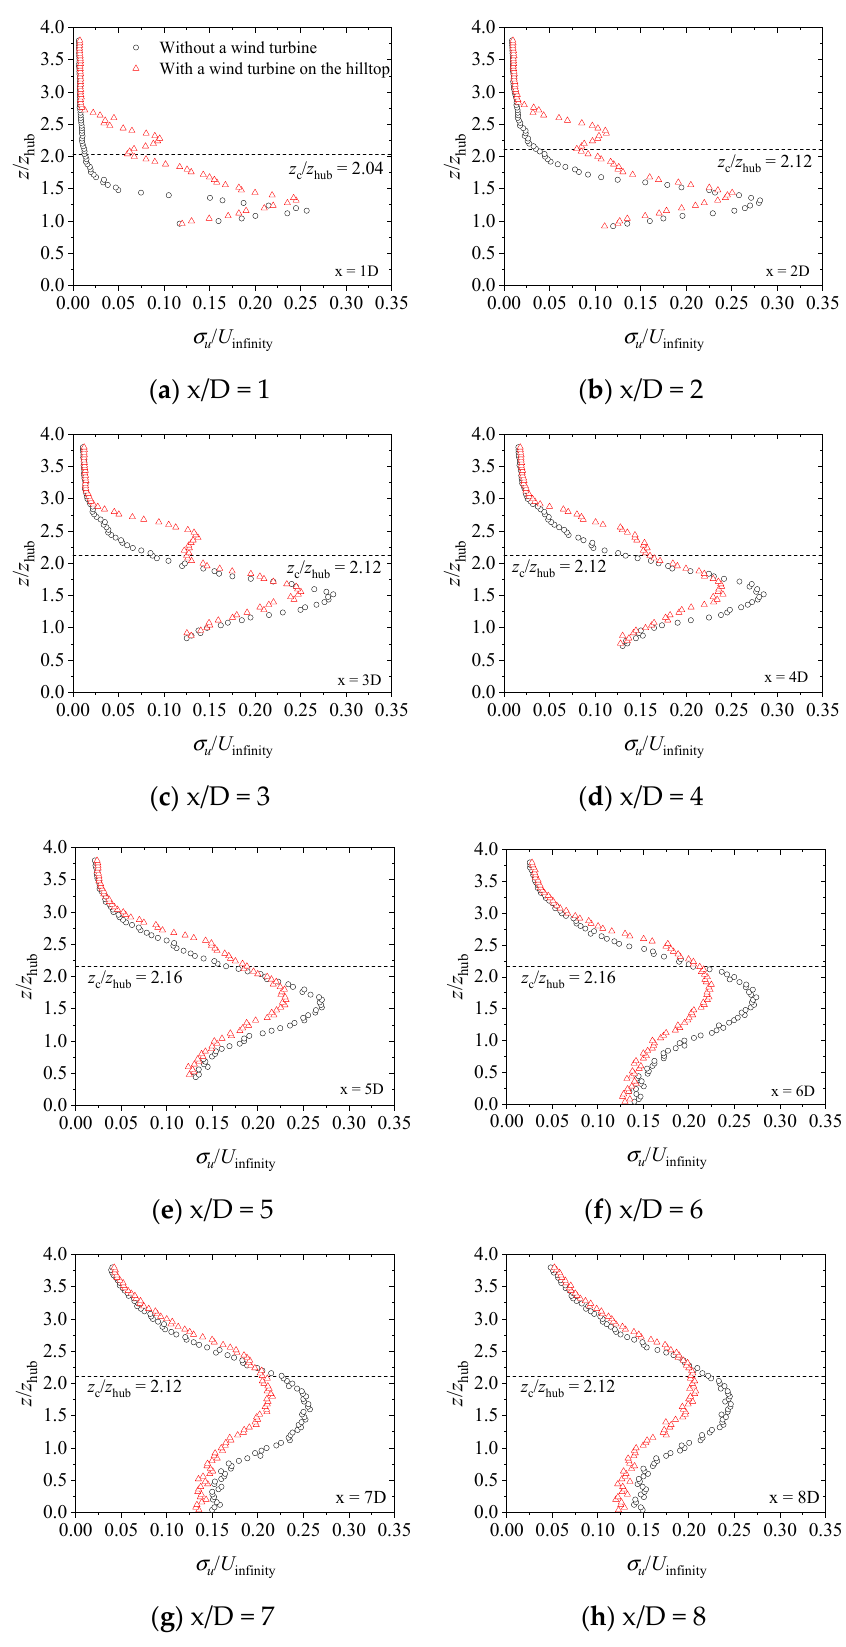
Figure 16. Vertical turbulence intensity distribution with and without a wind turbine located on the hilltop (case 4, x/D = 1 to 8).